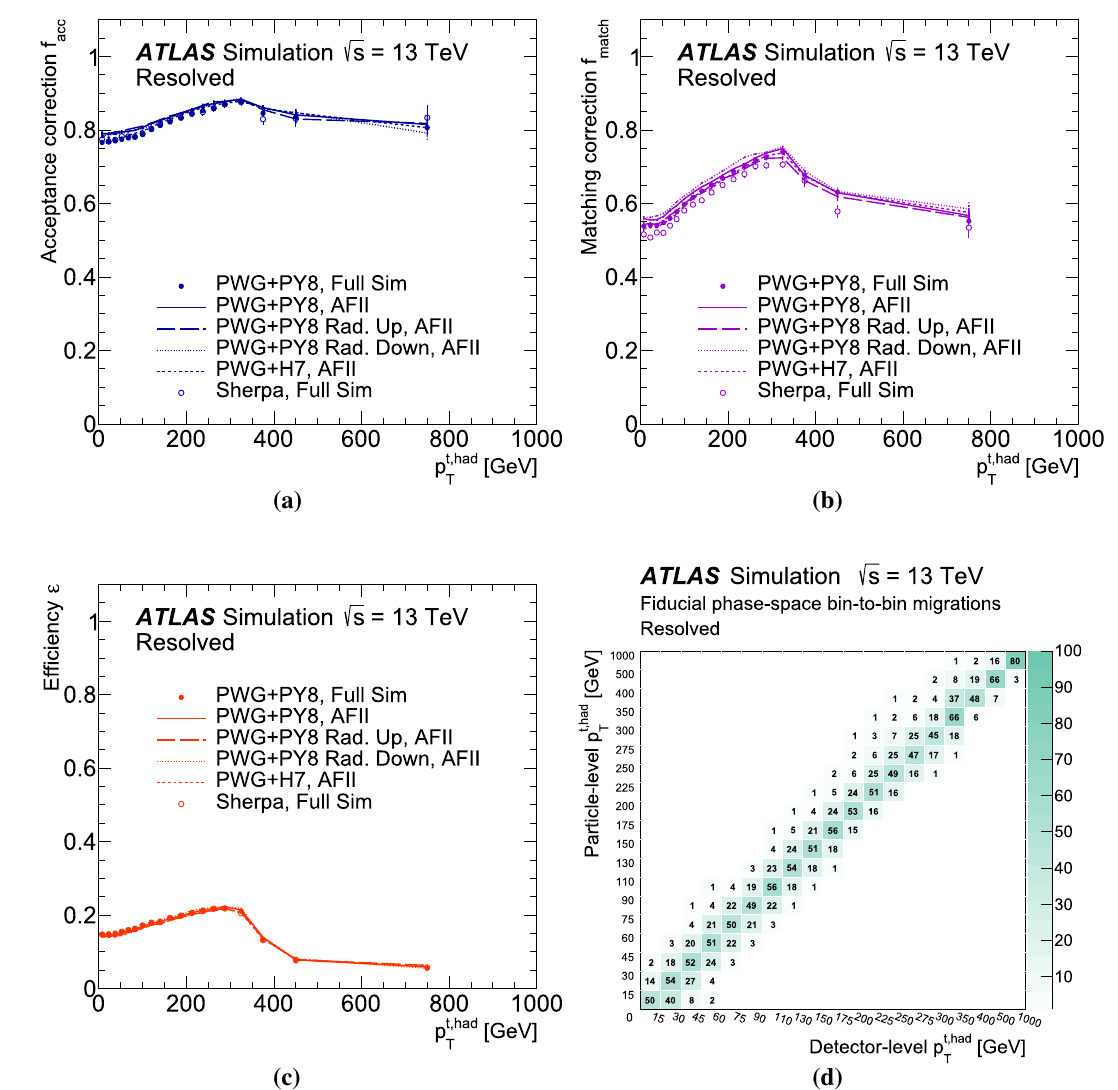
Fig. 13 The a acceptance f acc , b matching f match and c efficiency ε corrections (evaluated with the Monte Carlo samples used to assess the signal modelling uncertainties, as described in Sect. 9.2), and d the